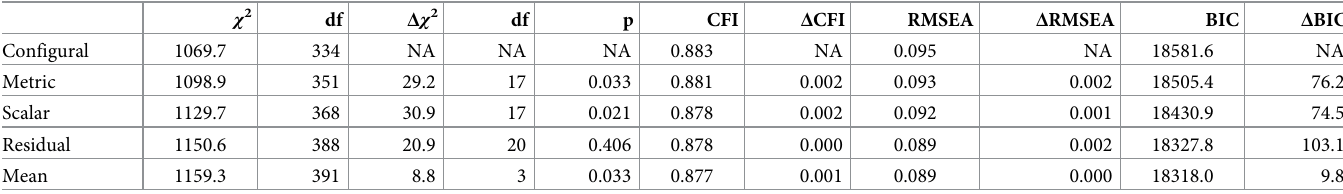
Table 3. Measurement invariance summary: Sample 1 (nationally representative adults, n = 492). χ 2 df Δ BIC Configural 1069.7 Metric